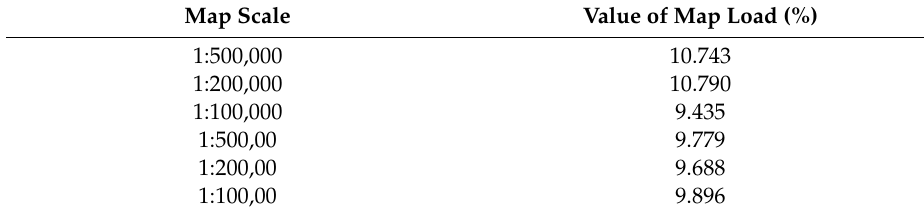
Figure 10. The horizontal axis represents Upper scale divided by Lower scale, and the vertical axis represents the radian values of geographical range area ratio. Table 3. Corresponding table of map scale and value of map load. Table 3. Corresponding table of map scale and value of map load.